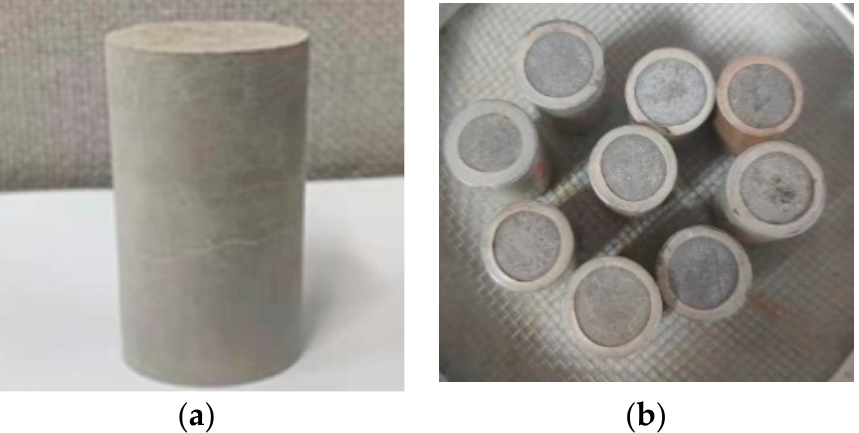
Figure 2. Preparation of plunger core samples of the mudstone biogas reservoir. ( a ) Samples obtained by wire-electrode cutting. ( b ) Core samples wrapped with a heat-shrinkable sleeve.